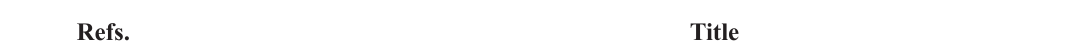
Table 2 – Review studies on constipation and LUTS in the literature.